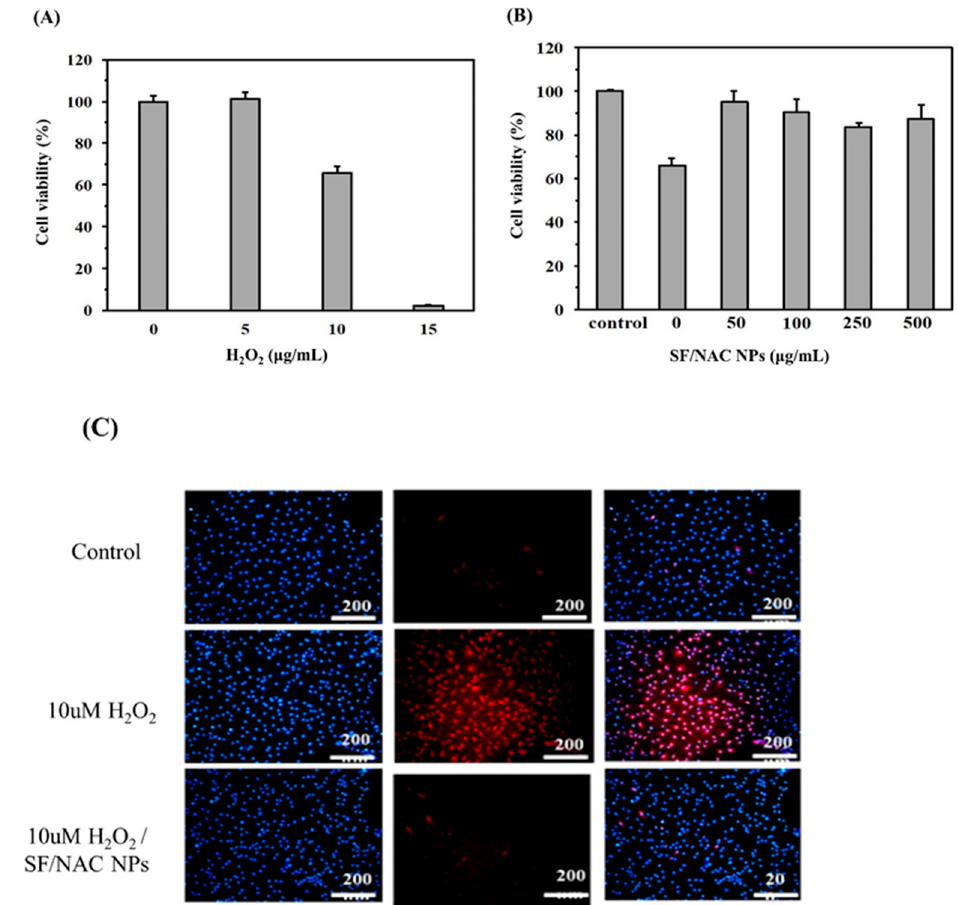
Figure 4. ( A ) HBMSC were incubated using different concentrations of H 2 O 2 for 24 h to determine the amount of H 2 O 2 that significantly reduced the cell viability of hBMSC. ( B ) Different concentrations of SF/NAC NPs were mixed with 10 µ g/mL H 2 O 2 and incubated with hBMSC to determine the viability of the cells and the anti-oxidative capabilities of SF/NAC NPs. ( C ) MitoSOX red stains for hBMSC cells were shown. The cells were incubated with 10 μ g/mL H 2 O 2 (red stain, MitoSOX) and 10 μ g/mL H 2 O 2 /100 μ g/mL SF/NAC NPs. There is no significant reduction in the intracellular ROS for the cells (rarely red stain) for the 10 μ g/mL H 2 O 2 /100 μ g/mL SF/NAC NPs group which was similar to the result for the control. (Note: stains for DAPI, blue; MitoSOX, red, respectively).